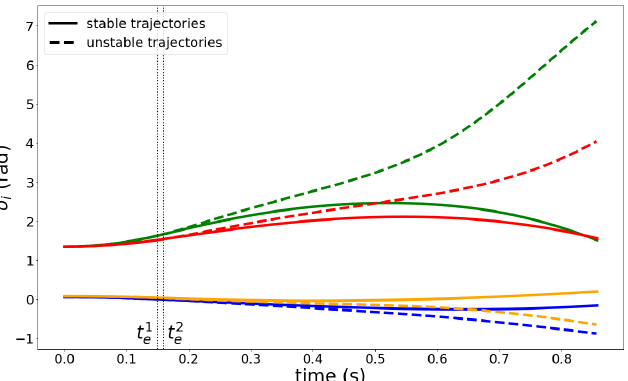
Figure 3. Time-angle trajectories of the four-machine power system obtained by time-domain simulation. Dashed and solid lines show unstable and stable trajectories,